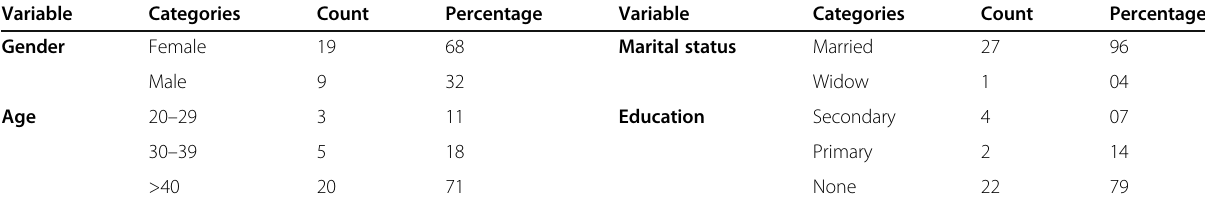
Table 1 Demographic profile of respondents ( n